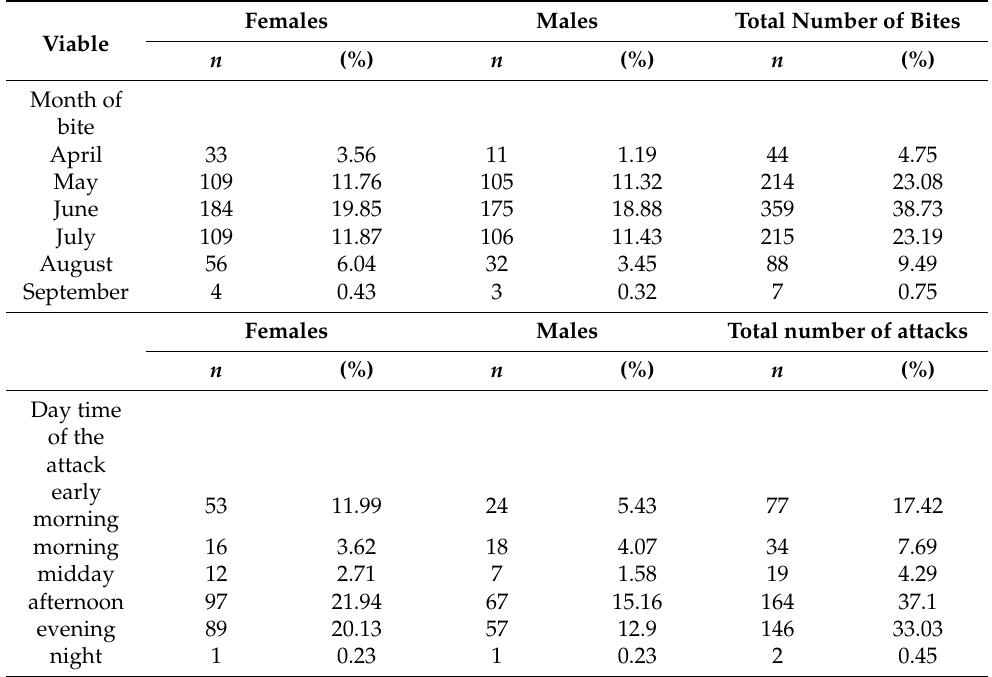
Table 2. Seasonal and diurnal occurrence of blackfly bites noted in Lubelskie Province (southeastern Poland (2003–2005, n =